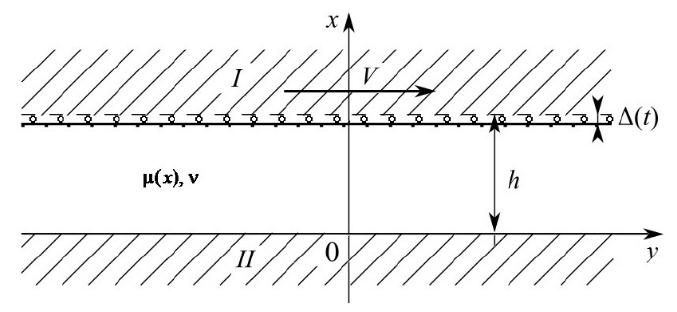
Figure 1. Scheme of the contact problem. In the described problem formulation, the temperature, stresses and displacements distributions in the coating do not depend on the horizontal coordinate y and are functions only of the vertical coordinate x and time t [37–41]. In the case of a quasi-static formulation without body forces, the stress state of the coating is described by the differential equations of equilibrium